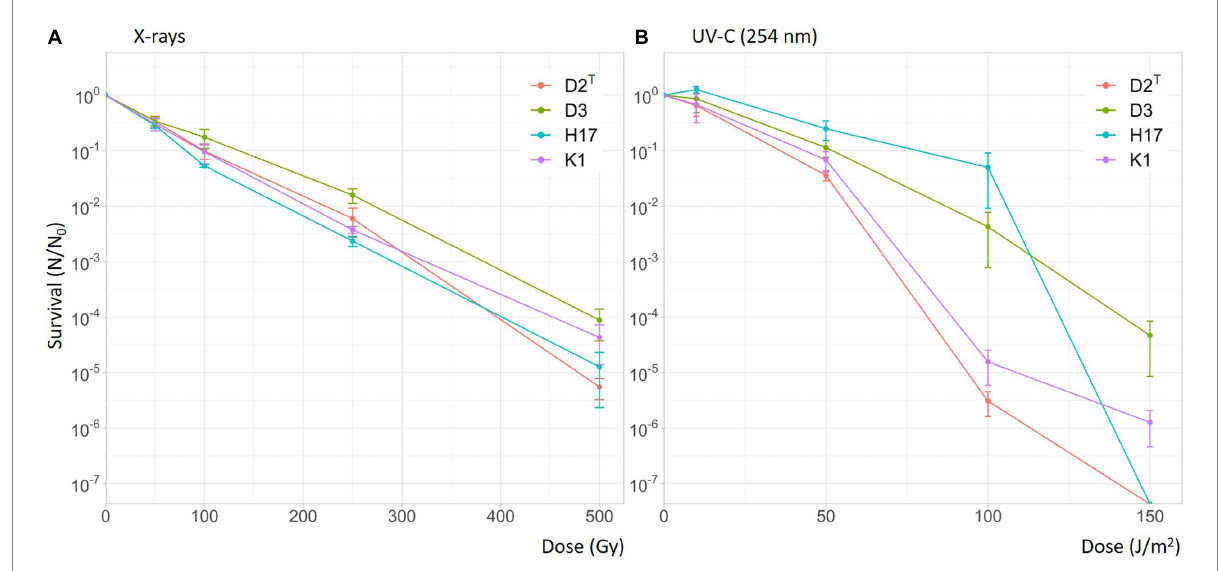
FIGURE 8 Survival of S. capitis during X-ray and UV-C irradiation in PBS. Initial cell counts used for irradiation were 10 7 CFU/mL. Irradiation experiments were performed in three biological replicates. Error bars represent the calculated standard error.